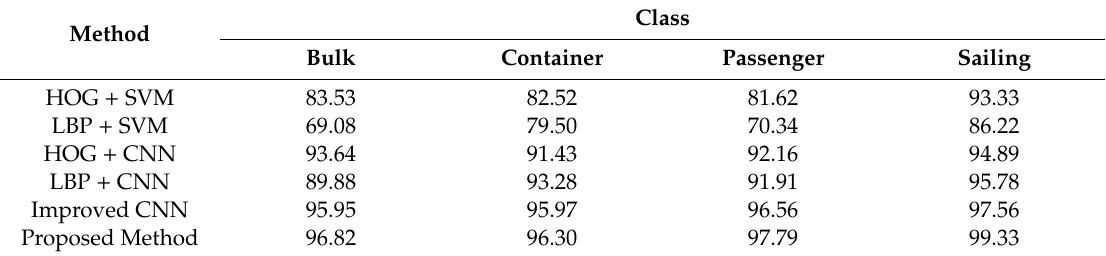
Table 9. Class-specific accuracy (%) of di ff erent methods for the self-built dataset.